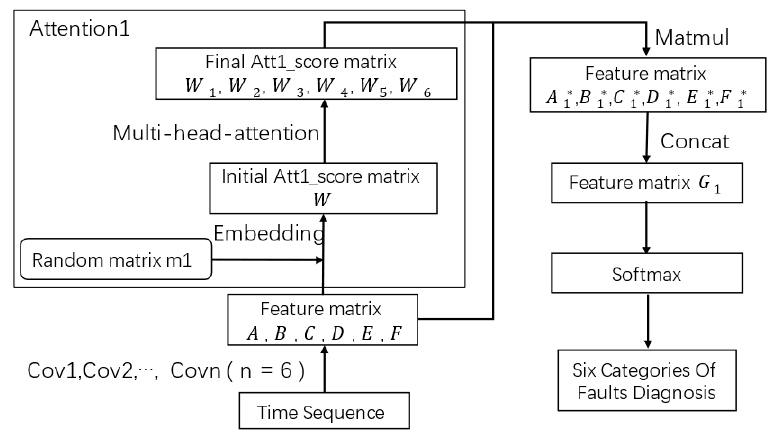
Figure 3. The single-layer attention convolution